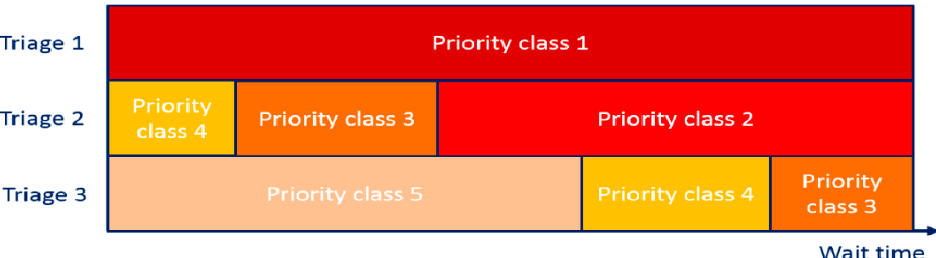
Figure 4. Delay-based triage systems to prioritize patients [49].